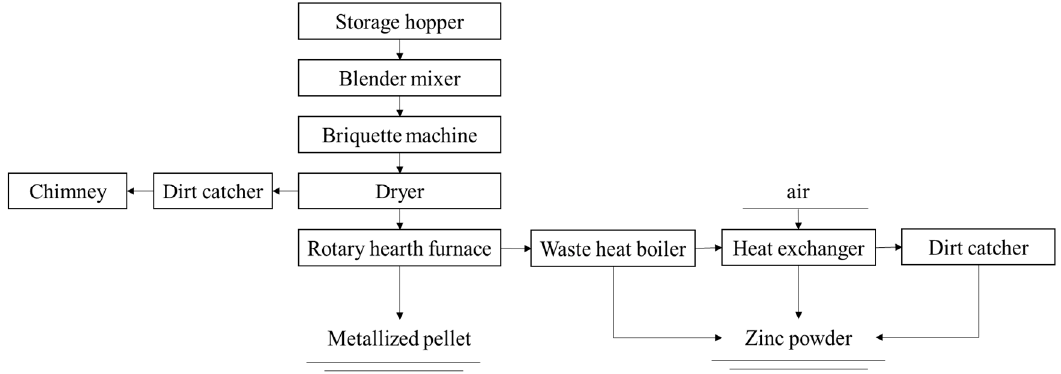
Figure 8. Flow chart of RHF process [32,38,39]. Figure 7. Flow chart of RHF process